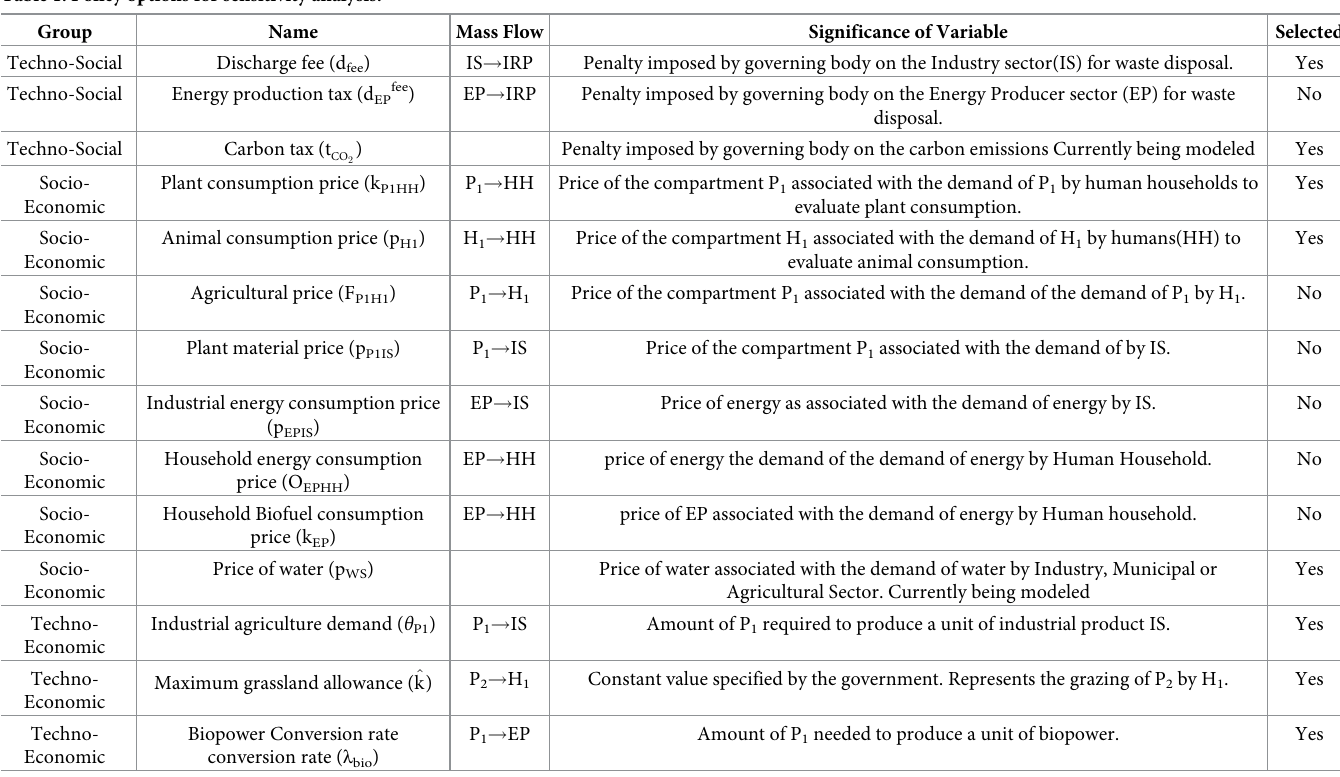
Table 1. Policy options for sensitivity